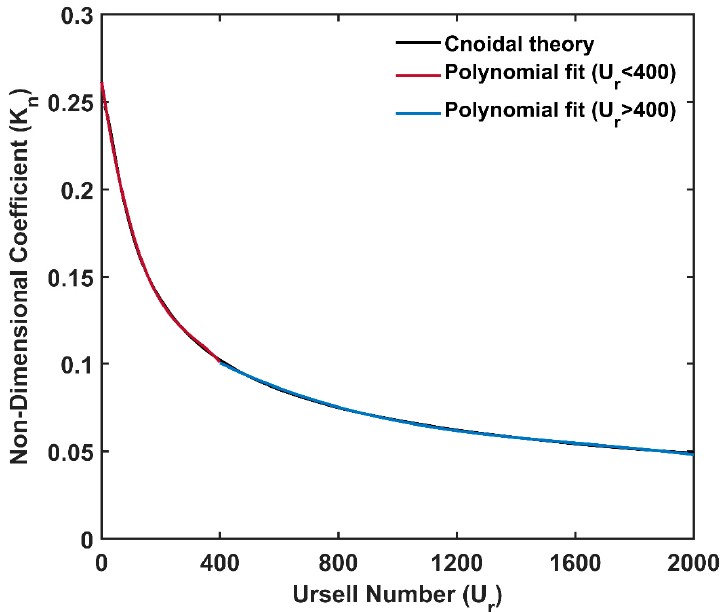
Figure 1. Non-dimensional transport coefficient ( K n ) as a function of the Ursell number ( U r ) and two polynomial least-square fits to different parts of the theoretical curve.